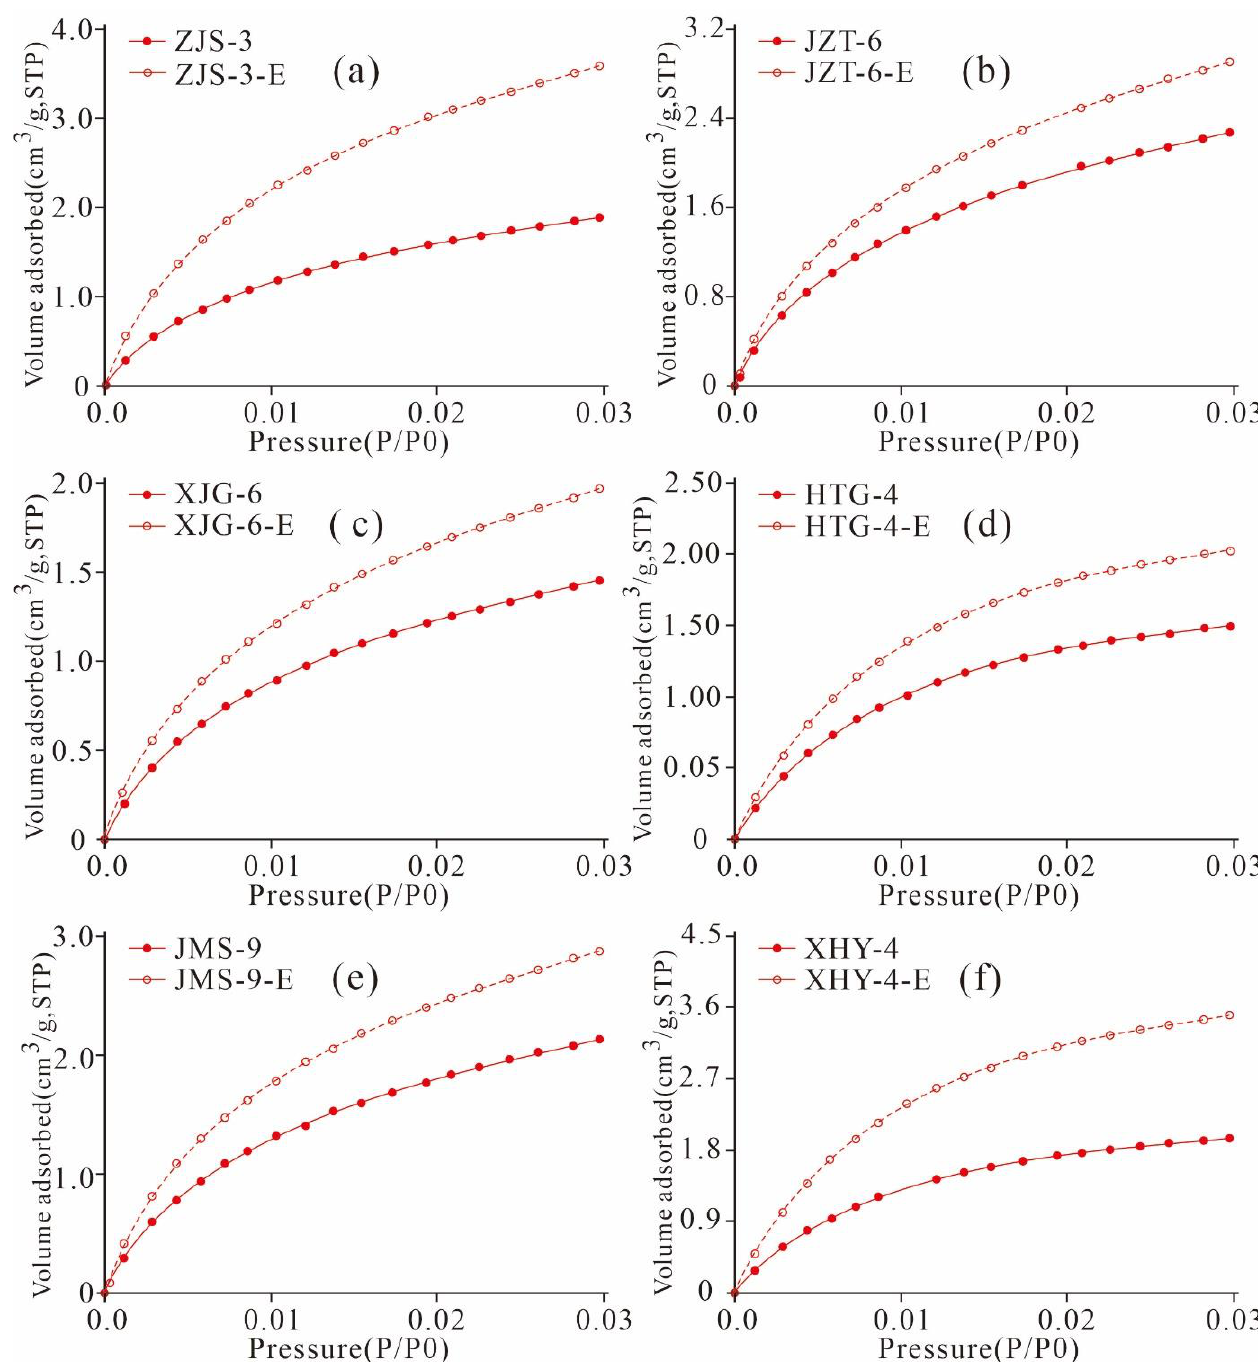
Figure 16. CO 2 adsorption isotherms of the original shale and extracted shale (( a ), ZJS-3; ( b ), JZT-6; ( c ), XJG-6; ( d ), HTG-4; ( e ), JMS-9; ( f ), XHY-4).